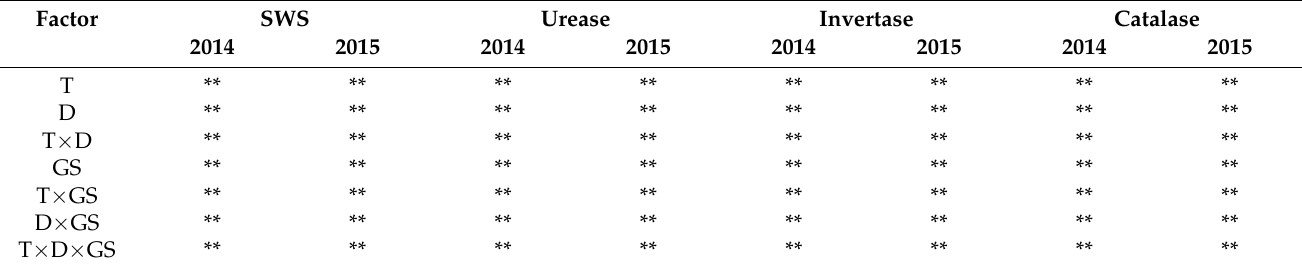
Table 3. Analysis of variance (ANOVA) for the effects of BHA treatments, soil depths, and growth stages on soil water storage and enzyme activities. Factor